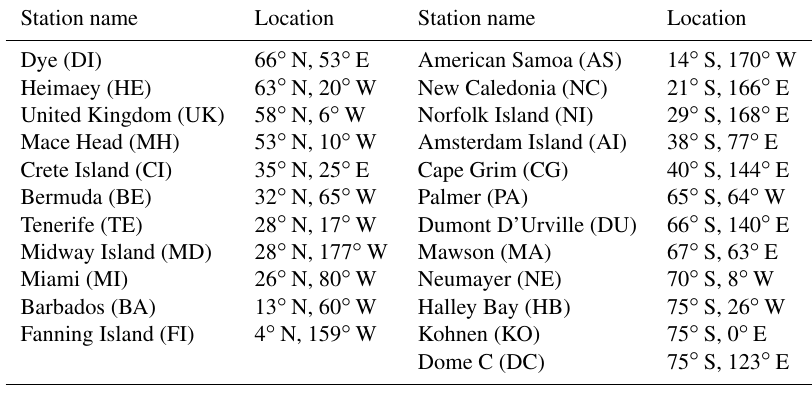
Table 5. The locations of the 23 stations that provide annual-mean MSA / nssSO 2 −